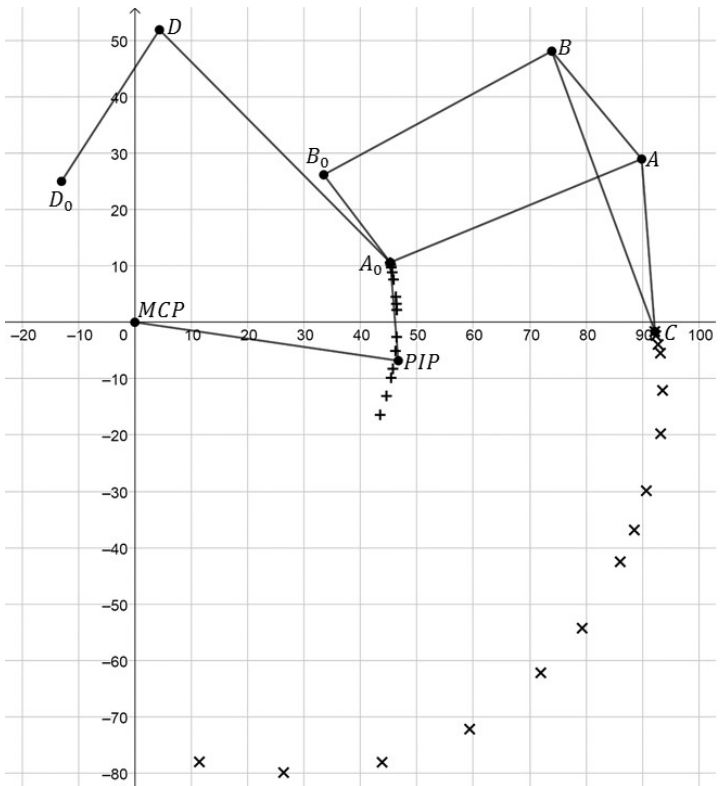
Figure 13. The synthesized kinematic design of the finger exoskeleton in Figure 3 with the trajectories of A0 and C indicated with plus ( + ) and cross (x) marks. Table 2. Design parameters and link lengths of the finger exoskeleton for the scheme in Figure 5.